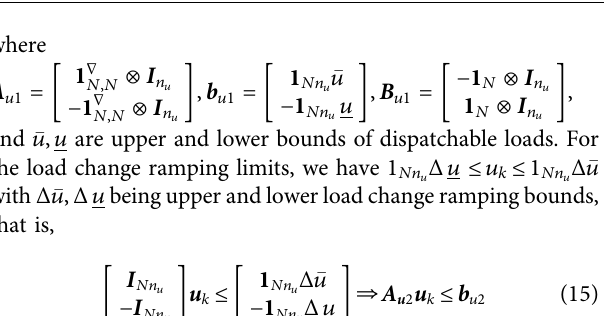
FIGURE 6 | Frequency constraint evaluation with tight input constraints: (A) frequency, (B) total load decrease, (C) RoCoF, and (D) load ramping.